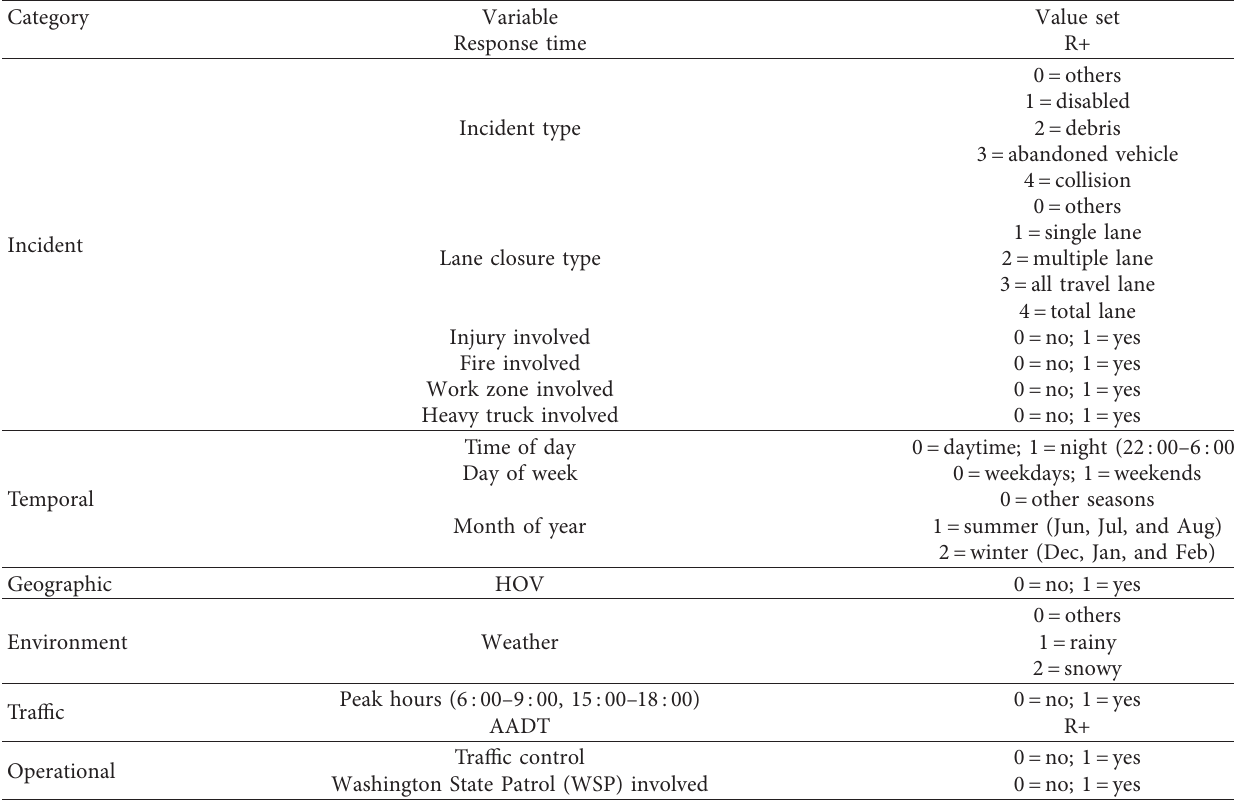
Table 1: Description of explanatory variables for clearance